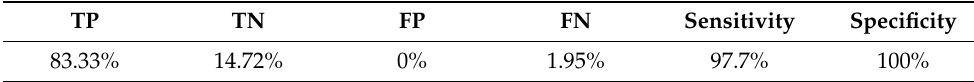
Figure 5. Confusion matrix ( A ) and ROC curve ( B ) for breast tumor DHL model. Table 3. Performance for breast tumor DHL model.